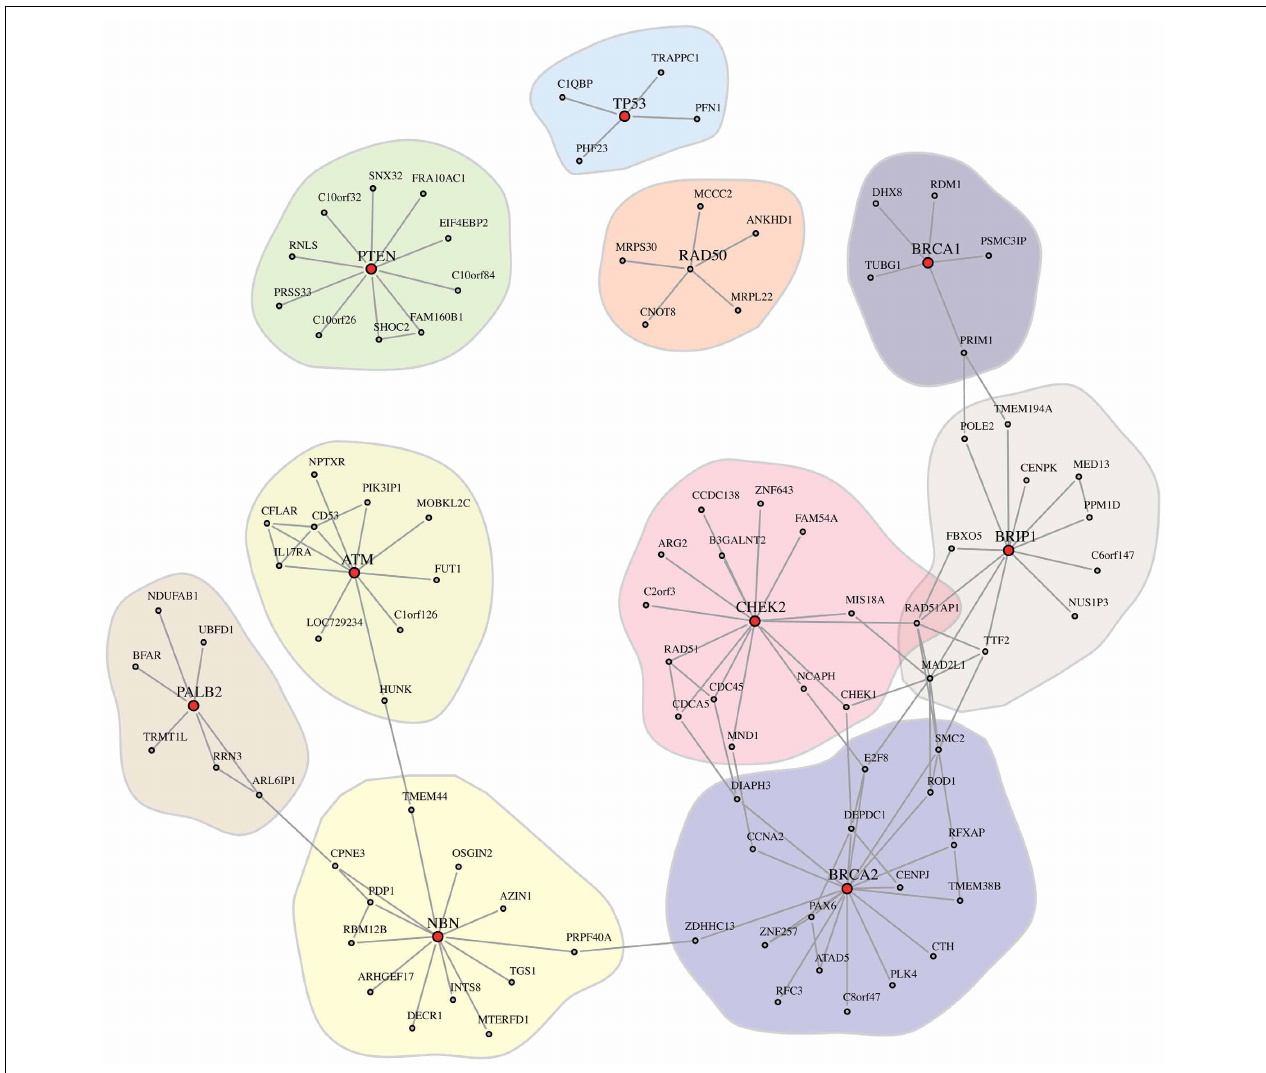
FIGURE 2 | Shown is the 1st degree neighbors subnetwork, G 1st , of the cancer genes BRCA1 , BRCA2 , TP53 , PTEN , CHEK2 , ATM , NBN (NBS1), RAD50 , BRIP1 , and PALB2 (highlighted in red),